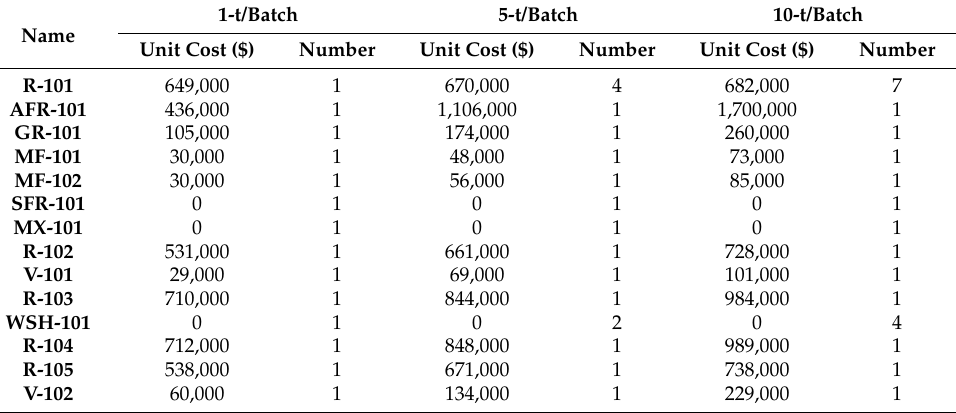
Table A4. Equipment unit cost and required number for different production scale of Ti